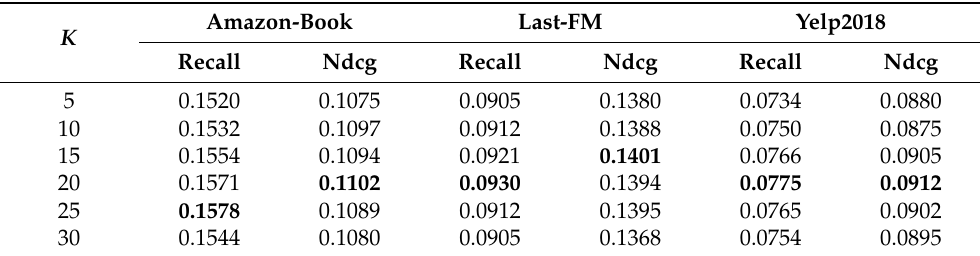
Table 5. Effect of the number of added